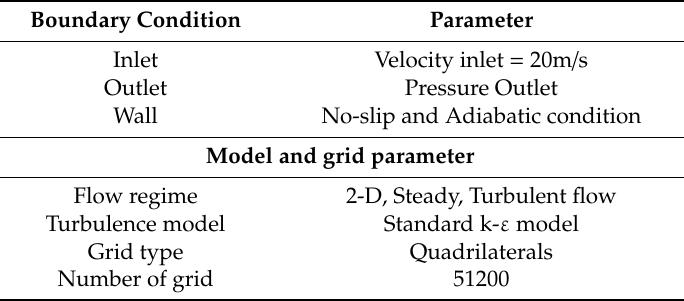
Figure 1. Schematic diagram of modeling and grid for simulation. Table 1. The boundary conditions and model